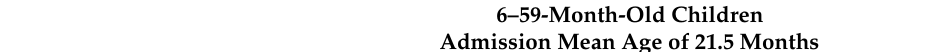
Table 4. Vitamin, mineral and inflammation status during the SAM effectiveness trial.